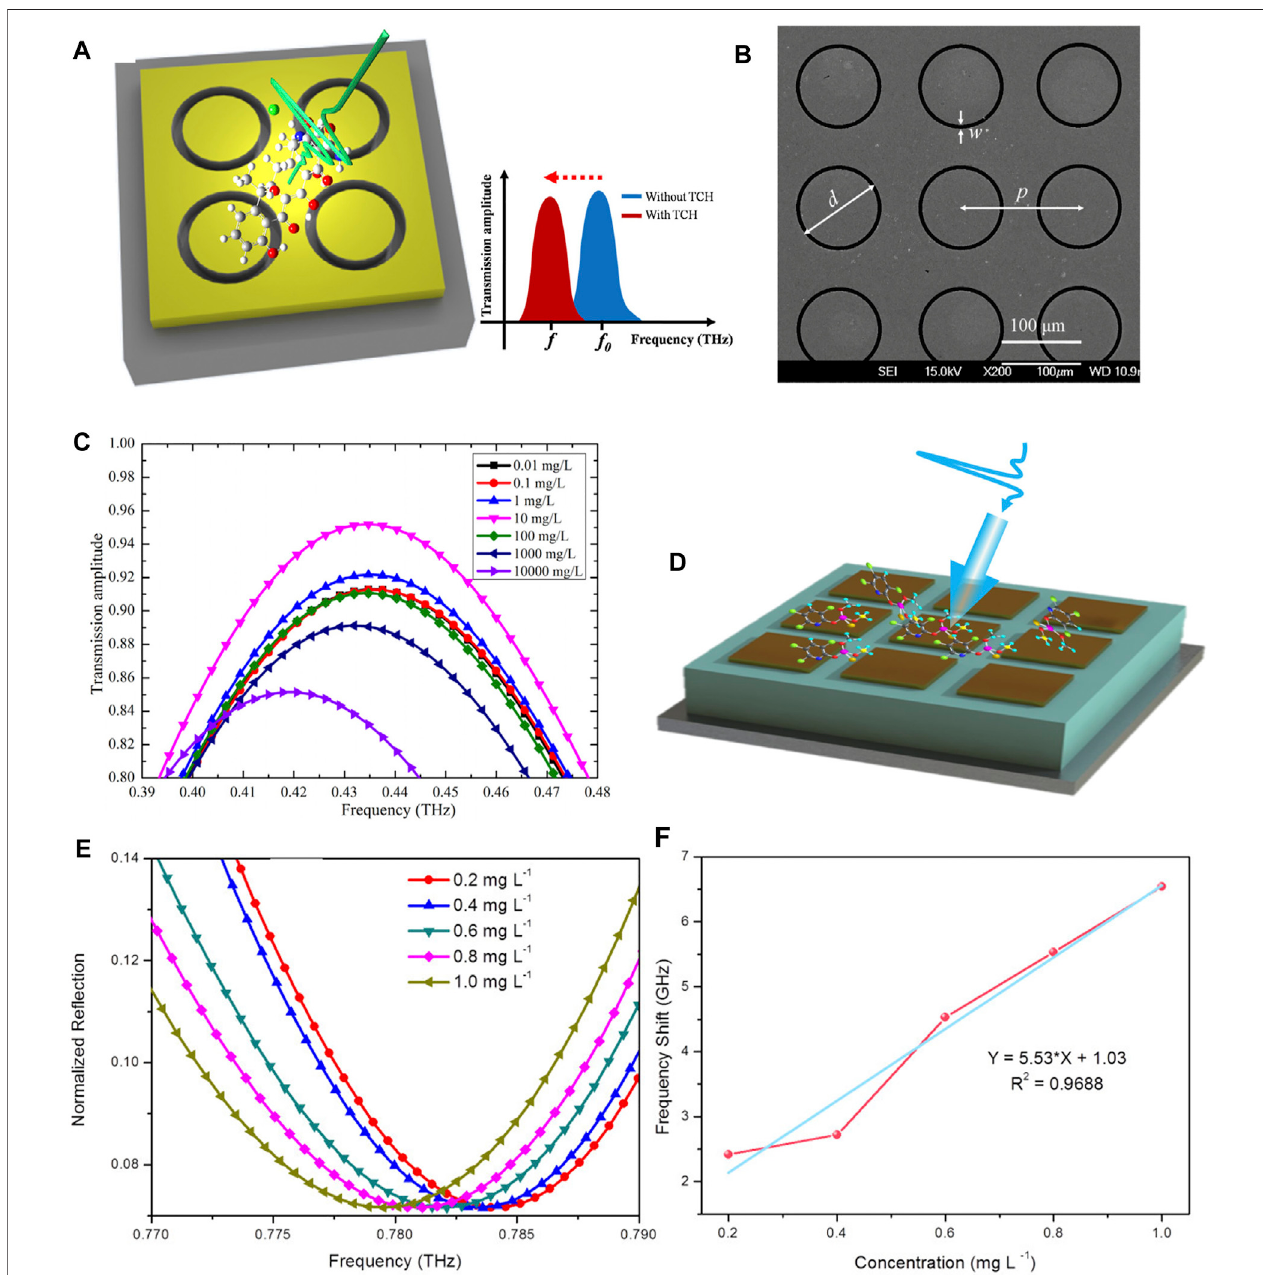
FIGURE7|(A) THzmetamaterialforthedetectionofTCHand (B) itsScanningElectronMicroscope(SEM)images (C) THztransmissionspectraofTCHdeposited on metamaterial detected at different concentrations [147]. Reproduced with permission. © 2016 Elsevier Ltd. (D) THz metamaterials for the detection of CM (E) THz re fl ectance spectra and (F) Frequency shift results of CM at different concentrations (0.2 – 1.0 mg/L), and the blue curve is a linear fi t to the data [148]. Reproduced with permission. © 2017 Elsevier